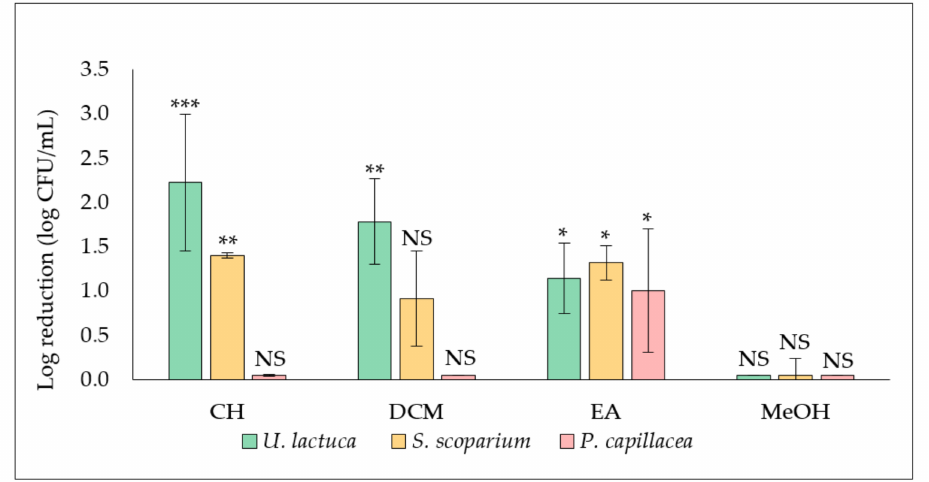
Figure 1. Effect of extracts (50.0 µ g/mL) derived from the green alga U. lactuca , the brown alga S. scoparium , and the red alga P. capillacea on S. aureus biofilm formation and growth. Extracts were added at t 0 . Results are expressed as means of log reduction in comparison with the related untreated control (log reduction (log CFU/mL) ± SD) from three independent experiments. Statistically significant differences (***, p -value < 0.001, **, p -value < 0.01, *, p -value < 0.05) between log CFU/mL number in the extract treated biofilm and that in the appropriate untreated control are indicated. CH, DCM, EA, and MeOH are cyclohexane, dichloromethane, ethyl acetate, and methanol extracts, respectively. NS: not